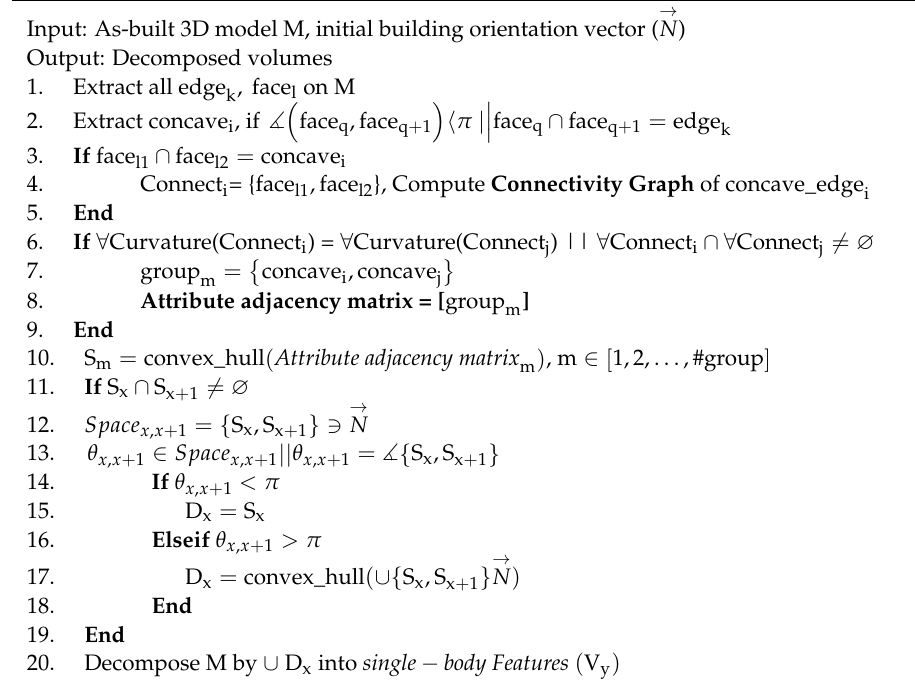
Algorithm 1: Autonomous creation of decomposed single ‐ body features.